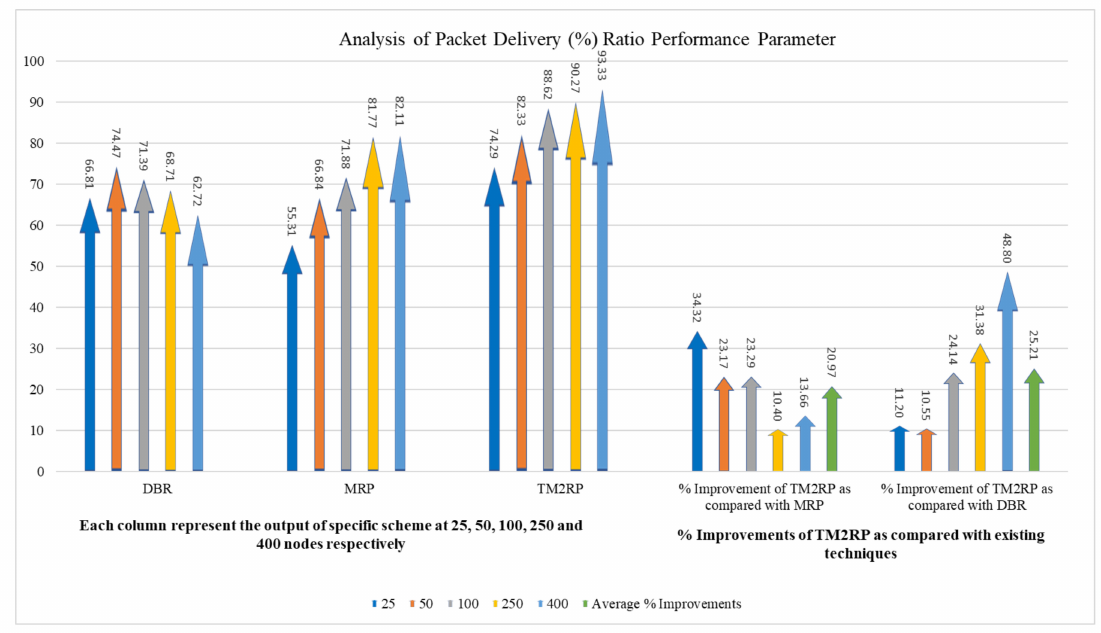
Figure 10. The statistical outcomes of the comparative protocols with regard to packet delivery